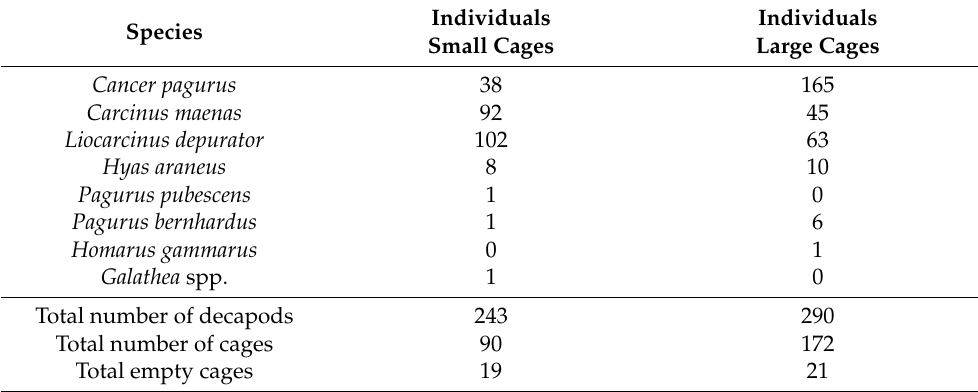
Table 2. Number of individuals of decapod species caught during all sampling years in small cages (90 cages total) and large cages (172 cages